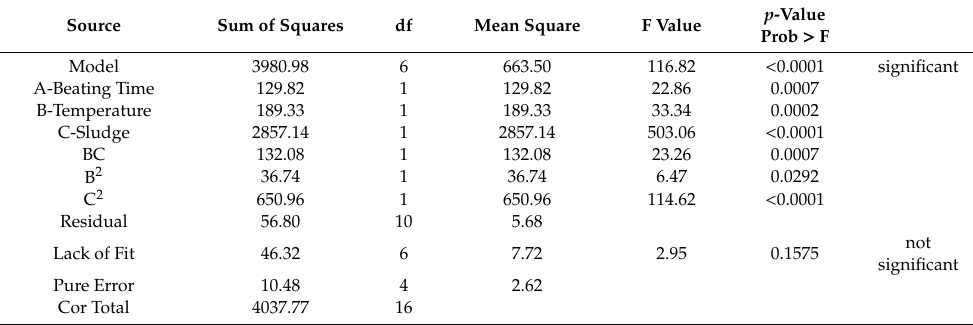
Table 15. ANOVA table for CO 2 % for AD of pot ale quadratic model α = 0.05. Source Sum of Squares